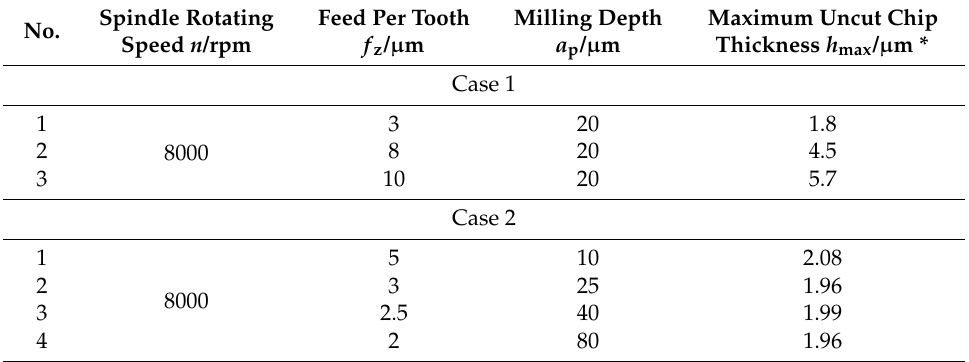
Table 3. Experimental parameters of the two